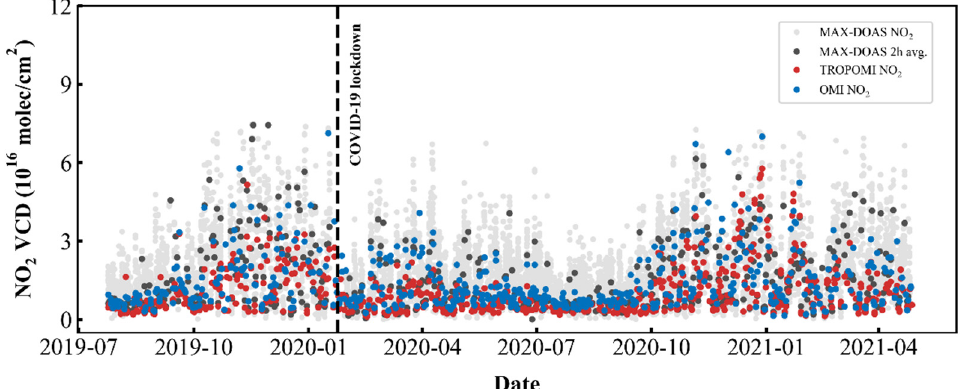
Figure 2. Time series of collocated TROPOMI, OMI and GB MAX-DOAS tropospheric NO 2 VCDs during the period from 24 July 2019 to 24 April 2021. Light grey dots denote all the available MAX-DOAS measurements; dark grey dots are the MAX-DOAS retrievals averaged within 2 h (12:30–14:30 LST) before and after satellite overpass time; red and blue dots are TROPOMI and OMI NO 2 data, respectively, within 50 km around Xianghe observatory.